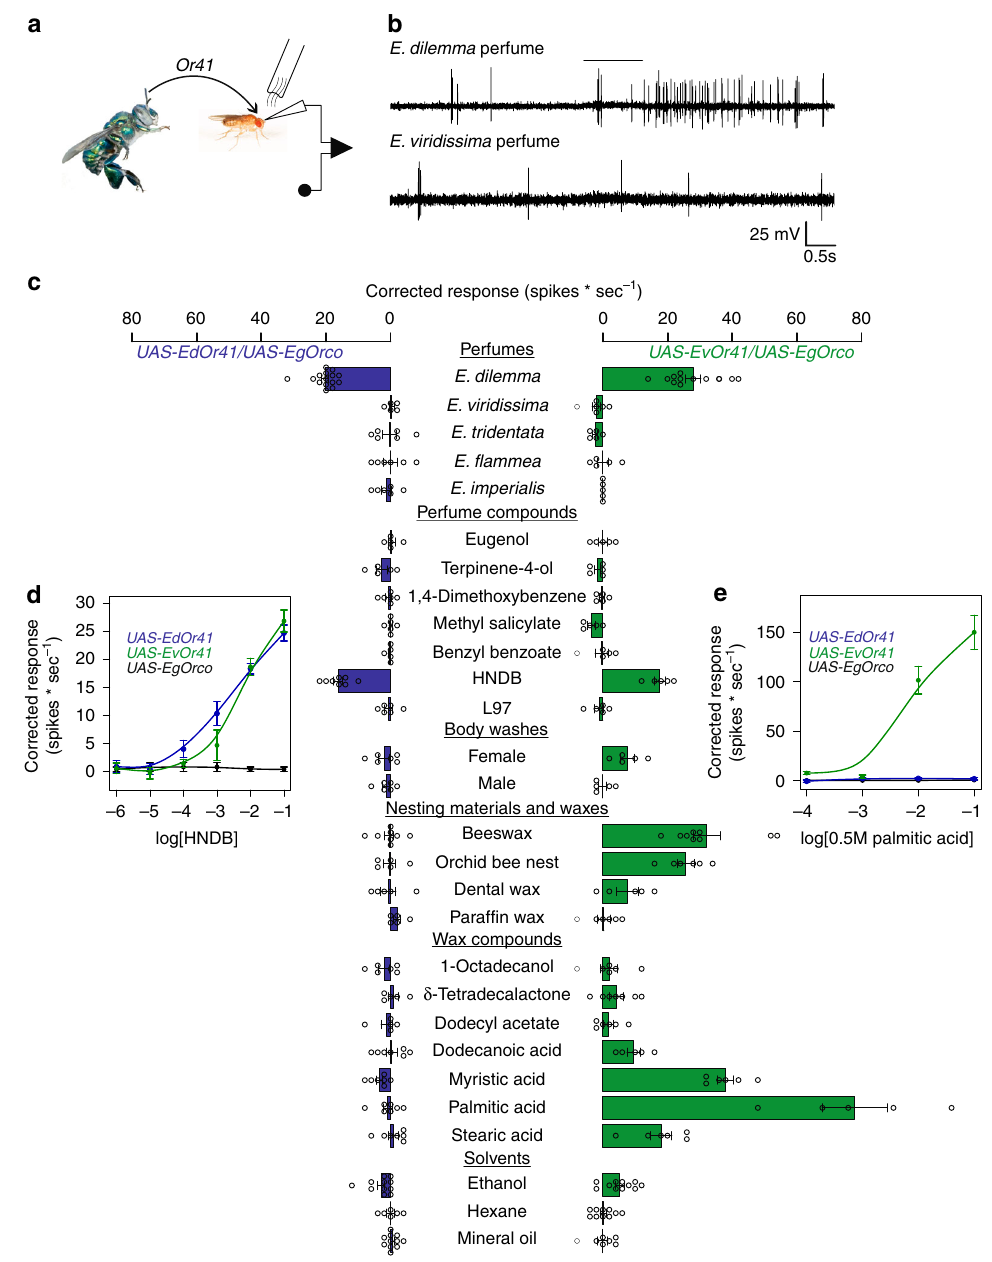
Fig. 4 Or41 is narrowly tuned to HNDB in E. dilemma . a Schematic of single sensillum recording. b Selective response of E. dilemma Or41 ( EdOr41 ) to conspeci fi c but not heterospeci fi c perfume blend as indicated by an increase in spike frequency upon application of the odor stimulus (black bar). c The derived EdOr41 variant (blue) responds speci fi cally to HNDB, whereas the conserved EvOr41 variant (green) responds to an array of odors and odor mixtures connected to natural waxes (mean ± SEM; n = 5 – 15). d , e Dose – response curves obtained from empty neurons expressing EdOr41 (blue), EvOr41 (green), or EgOrco (control, black) over EgOrco for HNDB ( d ) and palmitic acid ( e ). Pure compounds were diluted in mineral oil (1:100), 1,4- dimethoxybenzene, and fatty acids were diluted in ethanol (0.005 M), and all other odor blends were extracted in hexane. Error bars represent the SEM. Source data are provided as a Source Data fi